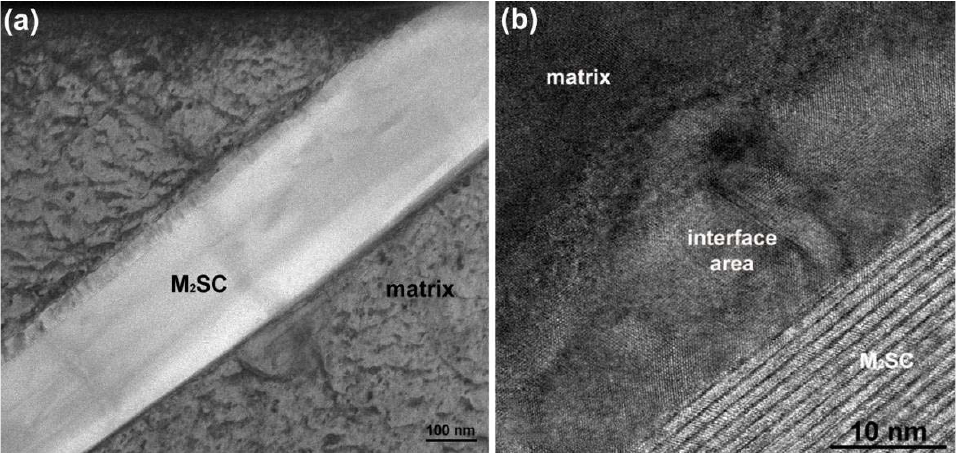
Figure 14. Microstructure of a M resolution